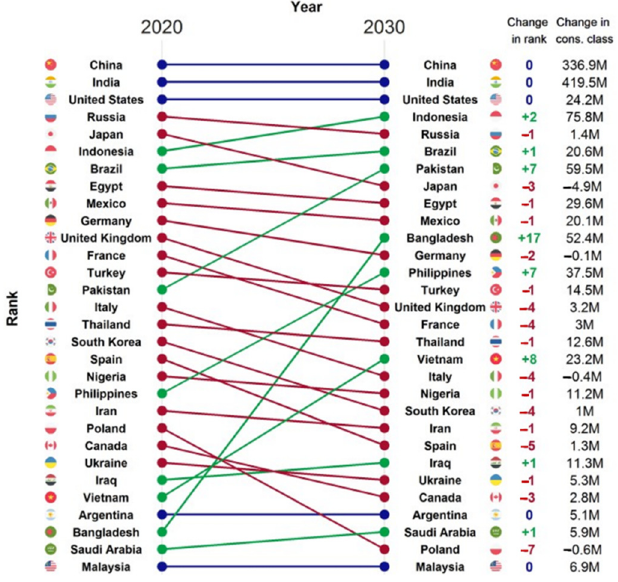
Figure 4. Top 30 largest consumer markets in the world (Unit: 1000 billion VND).